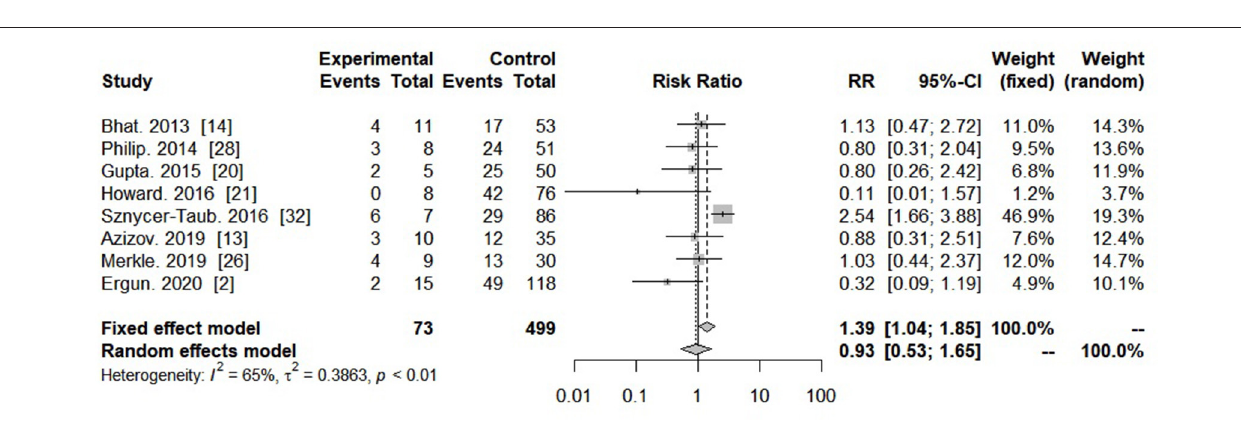
FIGURE 6 | Forest plot showing risk ratio of survival in genetic or non-genetic condition with post-cardiotomy extracorporeal membrane